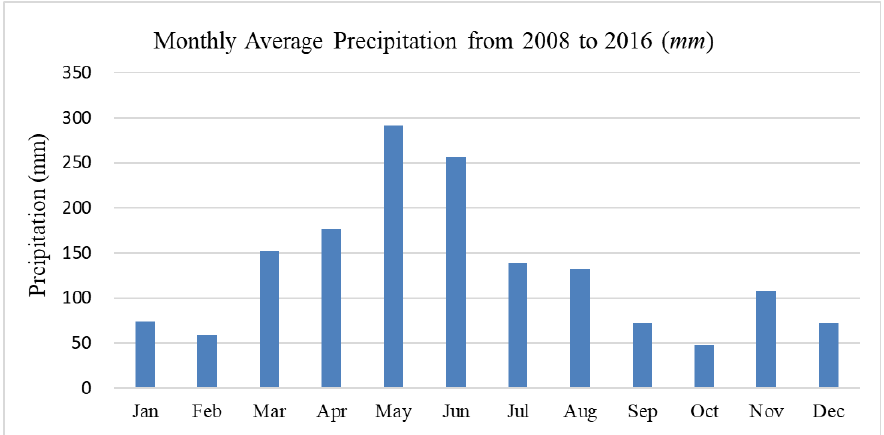
Figure 2. The monthly average precipitation from 2018 to 2016.